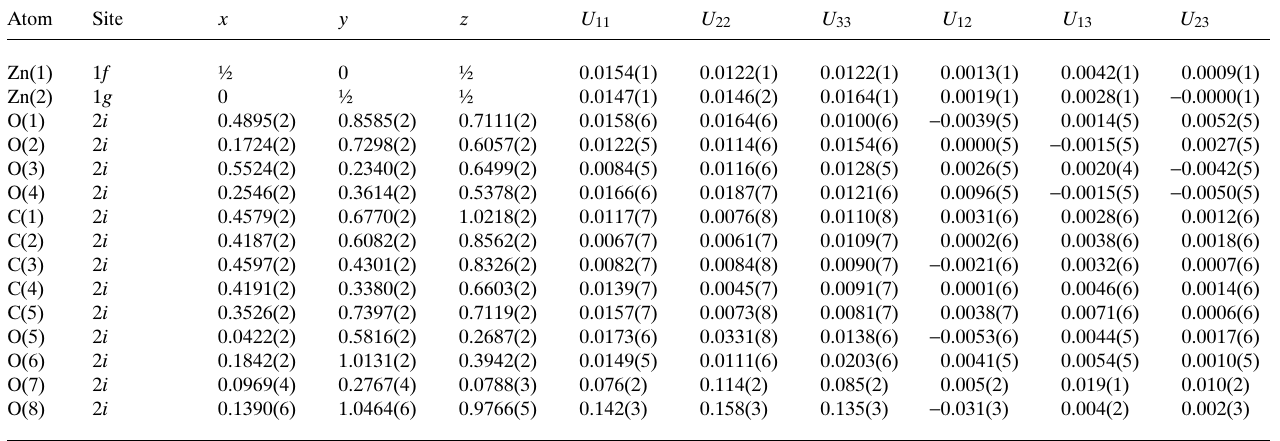
Table 3. Atomic coordinates and displacement parameters (in Å 2 ) .